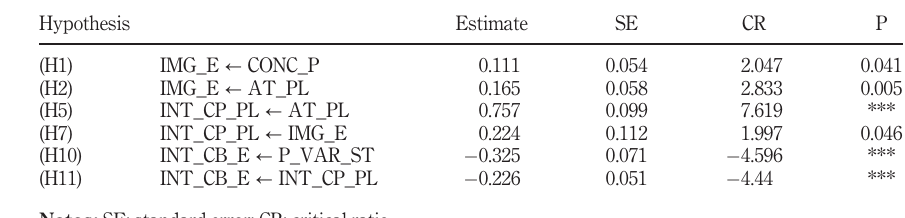
Table III. Final results